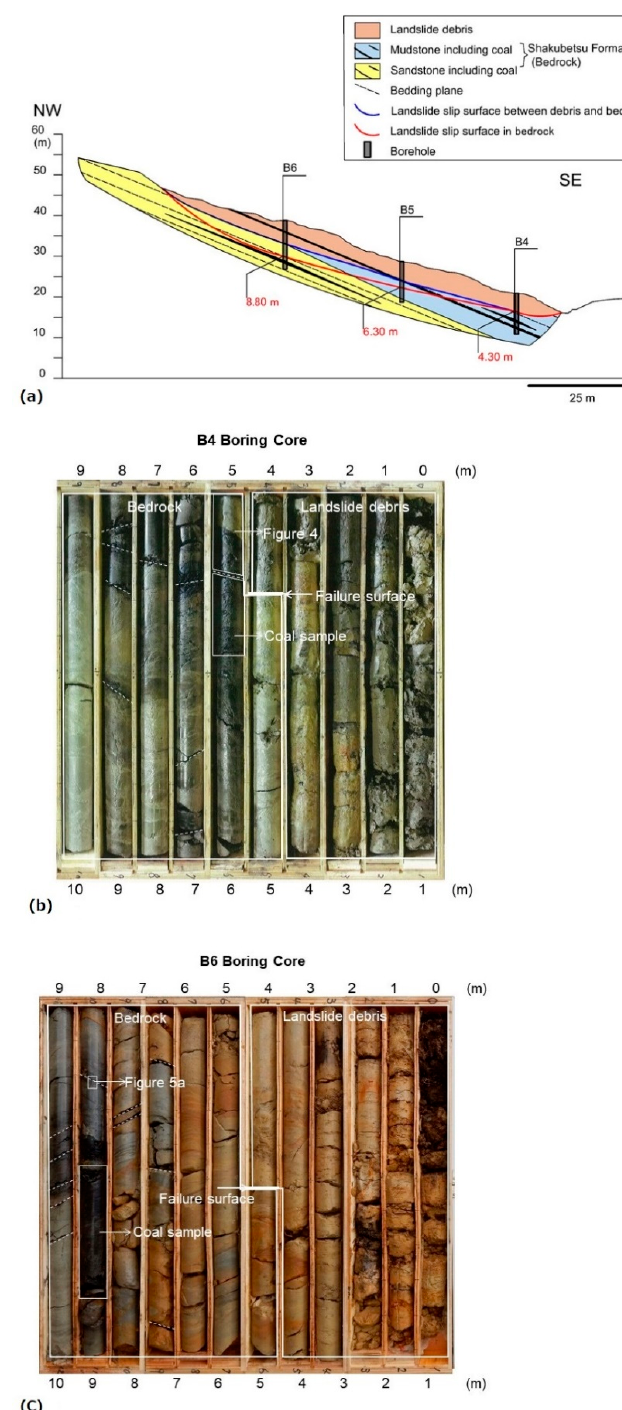
Figure 3. ( a ) Cross section of landslide and localities of boreholes (B4, 5 and 6). See Figure 1b,c for the drilled site. ( b , c ) Photographs of drilled core samples. ( b ) Borehole 4 (B4) core. ( c ) Borehole 6 (B6) core. Bedrock and landslide debris was divided by a failure surface, which was framed by white solid lines. Coal samples in ( b , c ) were those used for the vitrinite reflectance measurements (Table 2).